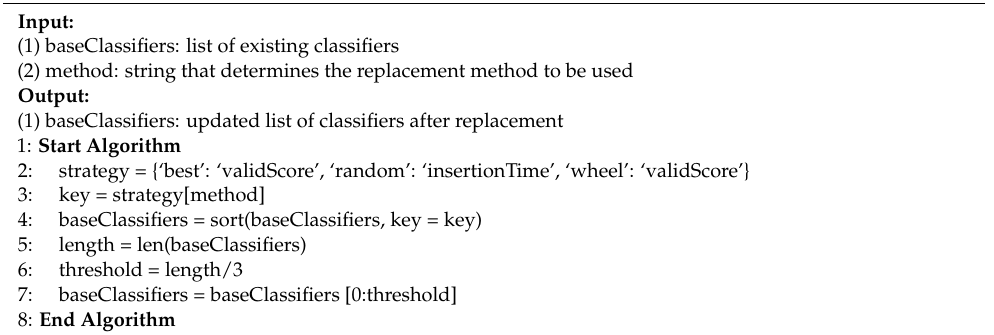
Algorithm 7. Pseudocode of model replacement for the incremental